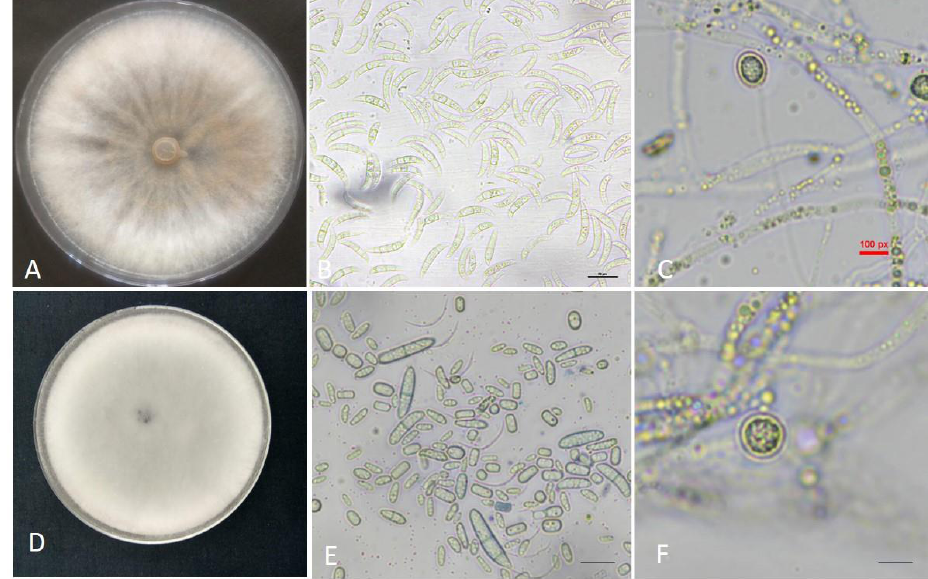
Figure 1. The morphological characteristics of Fusarium sambucinum and Fusarium solani ( A ) Pure culture Fusarium sambucinum on petri plate; ( B ) Macroconidia of Fusarium sambucinum ; ( C ) Chlamydospores ( D ) Pure culture Fusarium solani ( E ) Microconidia and macroconidia ( F ) Chlamydospores. The fungal spores ( B , C , E , F ) were observed under a compound microscope at 40 X magnification (scale bar: 100 µm).